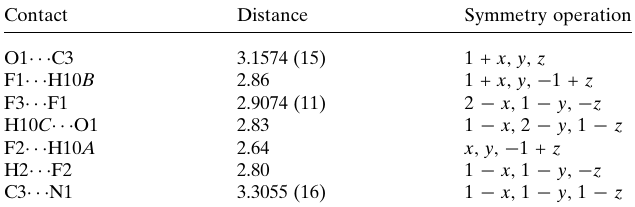
Table 2 Summary of short interatomic contacts (A˚ ) in the title structure. Contact